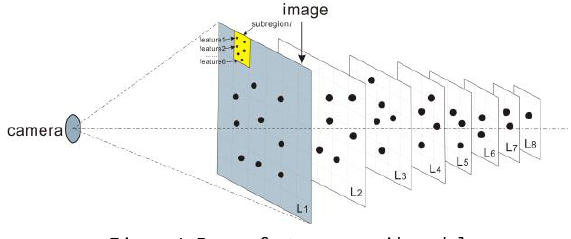
Figure 4. Image feature pyramid model